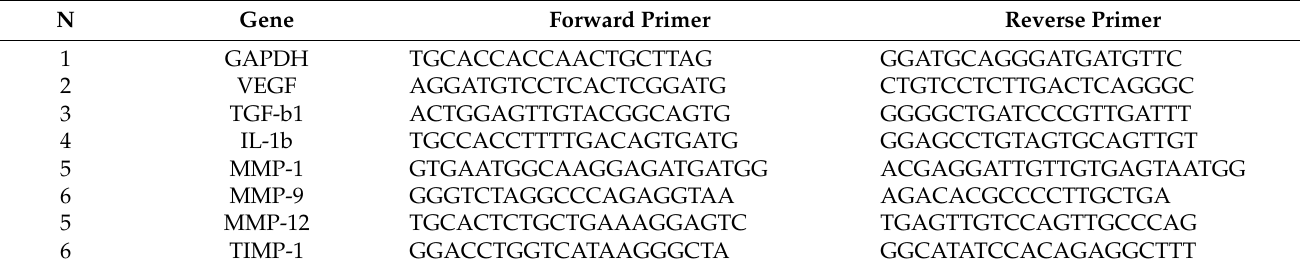
Table 1. Primers used in the